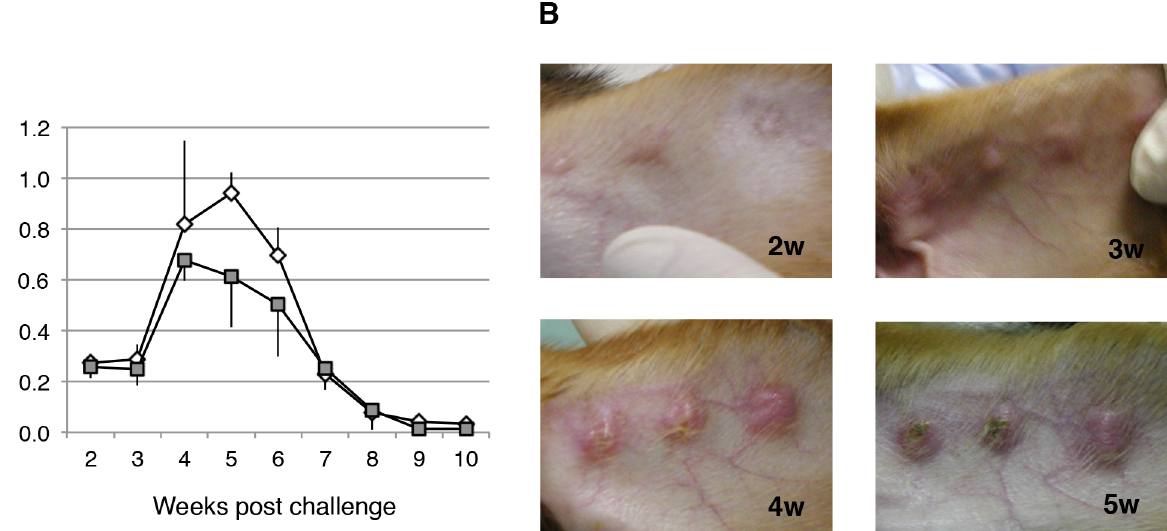
Fig 3. Time course of skin lesion development in dogs infected with L . major . (A) Beagle dogs were infected intradermally (in the ears) with 5 × 10 7 infective promastigotes of L . major per spot, and the lesion sizes were measured weekly. Parasite growth was evaluated as nodule size. Three independent spots per dog were determined and followed-up. Data are shown as means ± SEM, and the error bars reflect the three inoculated spots. (B) Images of lesions at 2 to 5 weeks after infection.